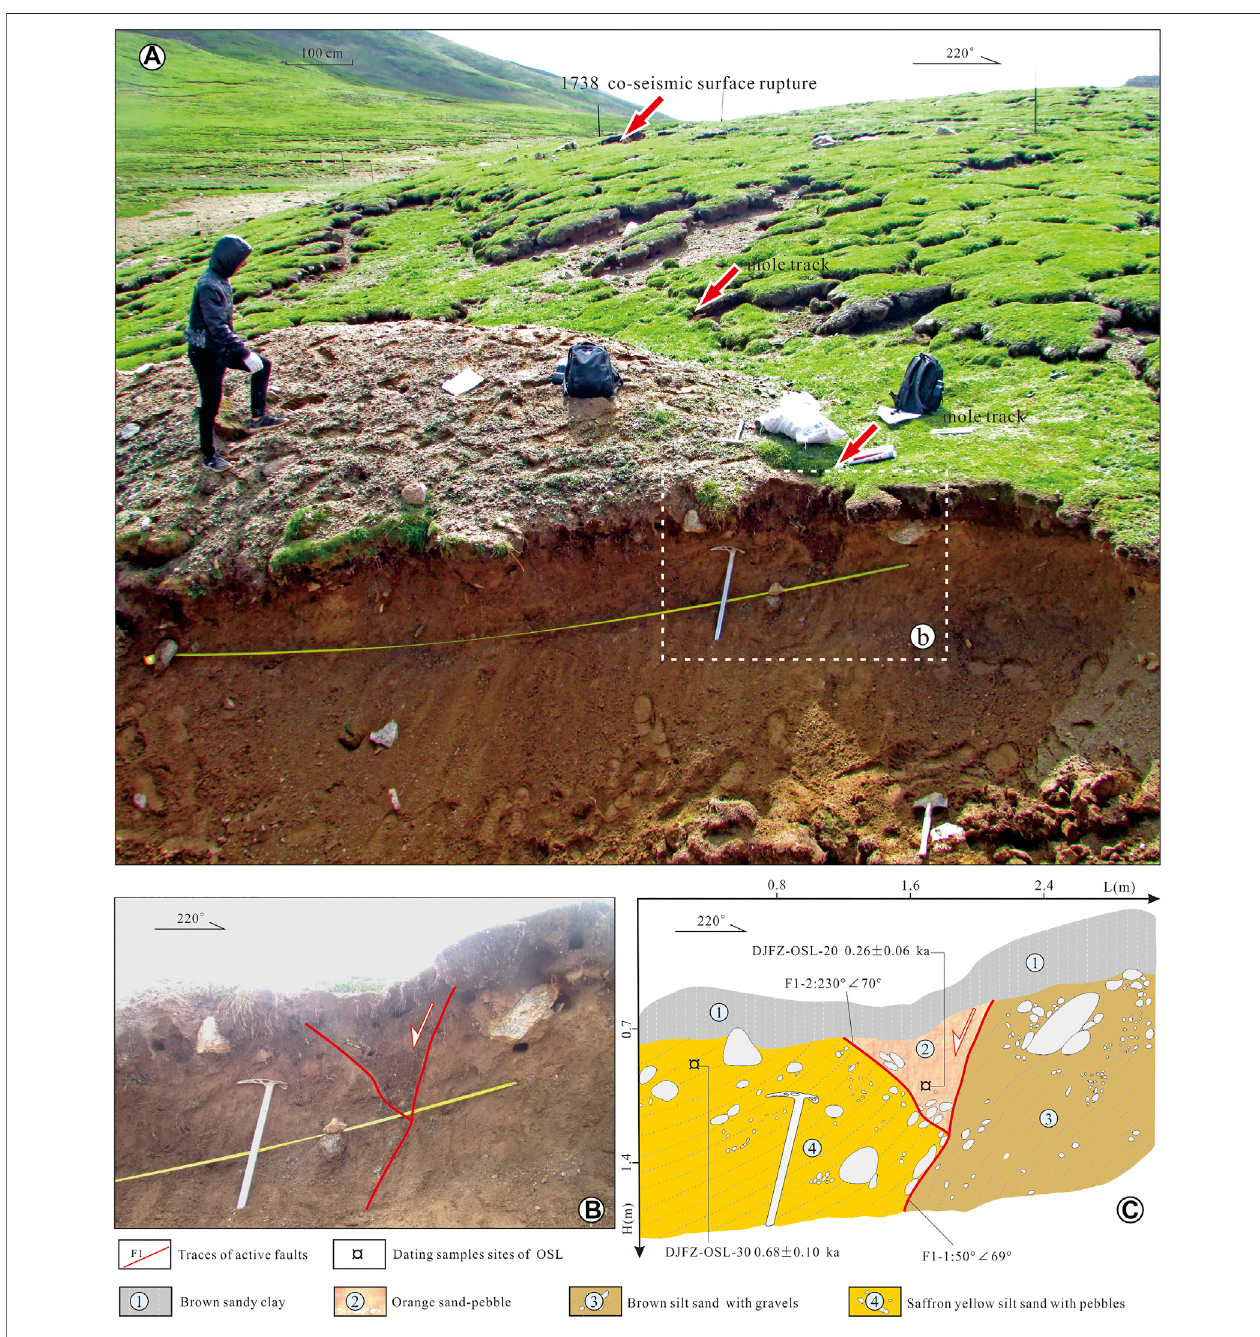
FIGURE5| WestwalllogsofthetrenchexcavatednearDangjiangrongvillage,andthesiteofthetrenchismarkedin Figure3 W. (A) Tectonicgeomorphicfeatures oftheDJFnearDangjiangrongvillage; (B) Originalpro fi leofthewestwall(CourtesyofLietal.,2012,unpublishedresults); (C) Interpretationmapofthewestwall.FaultF1 cuts the sediments of Units three to four and is overlain by Unit 1, while the wedge shape of Unit 2 may represent rapid transient accumulation after the earthquake (see the text for details). Fresh mole track structures are observed in the wall. Note the ice-axe in maps for scale.